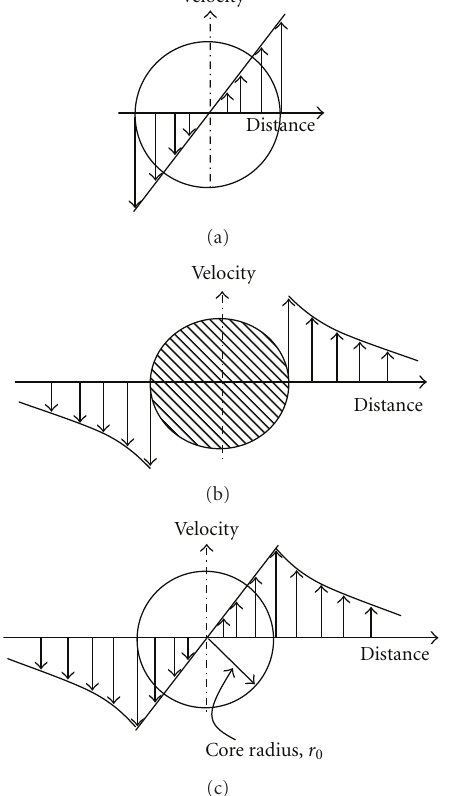
Figure 1: Velocity distribution in (a) solid body rotation, (b) potential vortex, and (c) Rankine